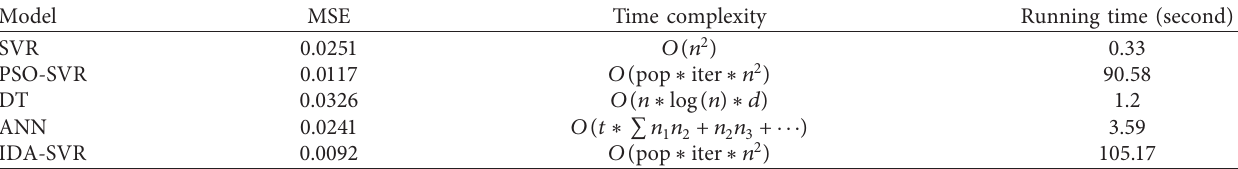
Table 6: Comparison of performance between IDA-SVR and other models.